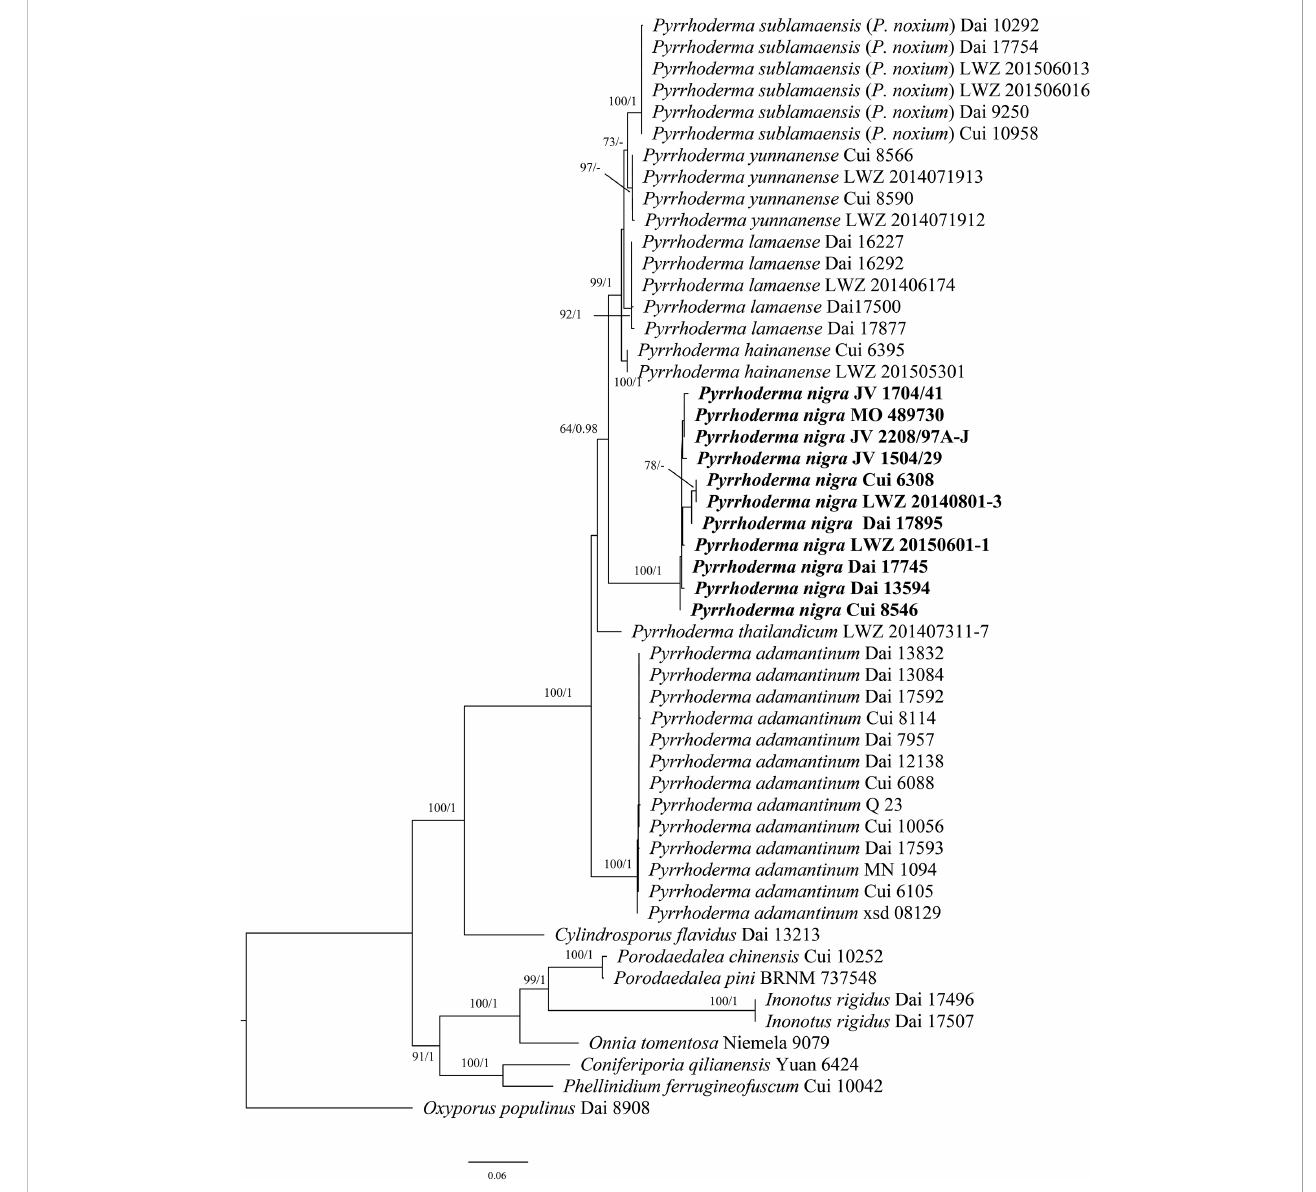
FIGURE 2 Maximum likelihood tree illustrating the phylogeny of Pyrrhoderma based on the combined dataset of ITS+28S sequences. Oxyporus populinus (KY131887; KT203323) was used as an outgroup. The maximum likelihood bootstrap values ( ≥ 50) and Bayesian posterior probability values ( ≥ 0.90) are indicated above the branches. The new species is in